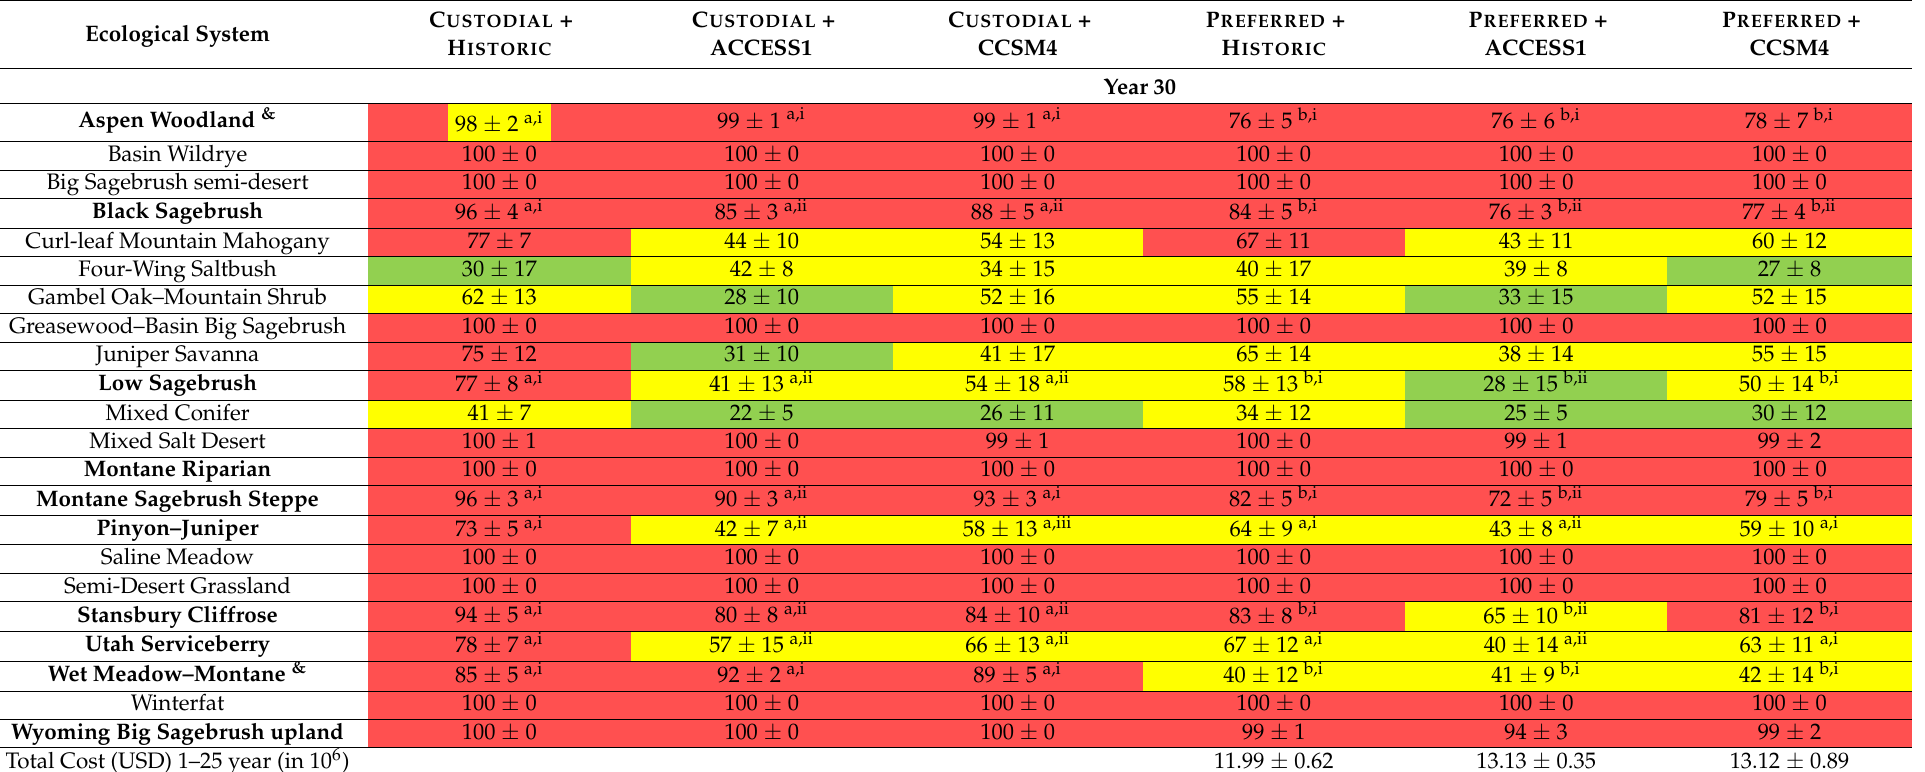
Table 6. Mean unified ecological departure of ecological systems (% ± 95% C.I., n = 10) and cost of active scenarios 30 and 60 years later for all scenarios. Systems in boldface were selected for active management. The letters “a” and “b” adjacent to UED values denoted significantly different ( p ≤ 0.05) means based on the test of Custodial vs. Preferred management. The “i” and “ii” adjacent to UED values indicated two significantly different LOCA preplanned comparisons using contrasts: Historic vs. LOCAs and CCSM4 vs. ACCESS1. Montane riparian and Wyoming big sagebrush were not testable due to lack of variance across all management treatments. UED colors are explained in the caption of Table 5; moreover, the color green is UED ≤